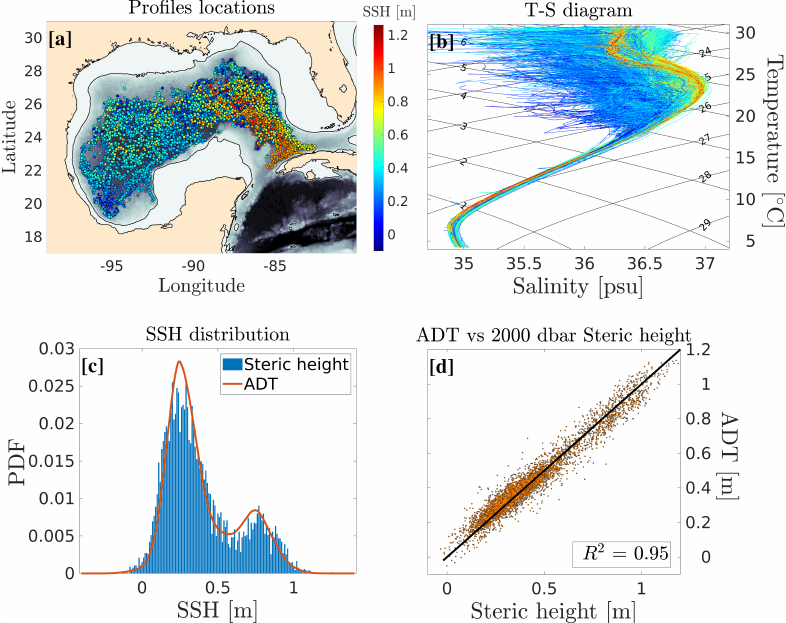
Figure 1. ( a ): Location of all available ARGO profiles in the Gulf of Mexico. The local 2000 dbar- referenced steric height is color coded. ( b ): T-S diagram of all ARGO profiles. The color code is the same as in panel ( a ). The black contours are isopleths of spice and potential density. ( c ): Distributions (normalized PDF) of the 2000 dbar-referenced steric height computed from in situ data (blue bars) and the gridded absolute dynamic topography (ADT) data (orange line). ( d ): 2000 dbar-referenced steric height against